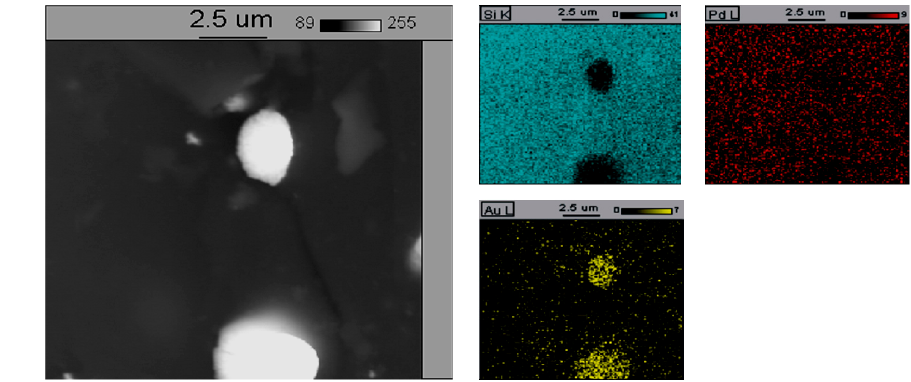
Figure 5. The back-scattered electron (BSE) photomicrograph of the ( A )—5%Pd/SiO 2 , ( B )—5%Pd- 1%Au/SiO 2 , and ( C )—5%Pd-5%Au/SiO 2 catalyst. The catalysts were previously reduced in H 2 at 300 °C for 2 h.